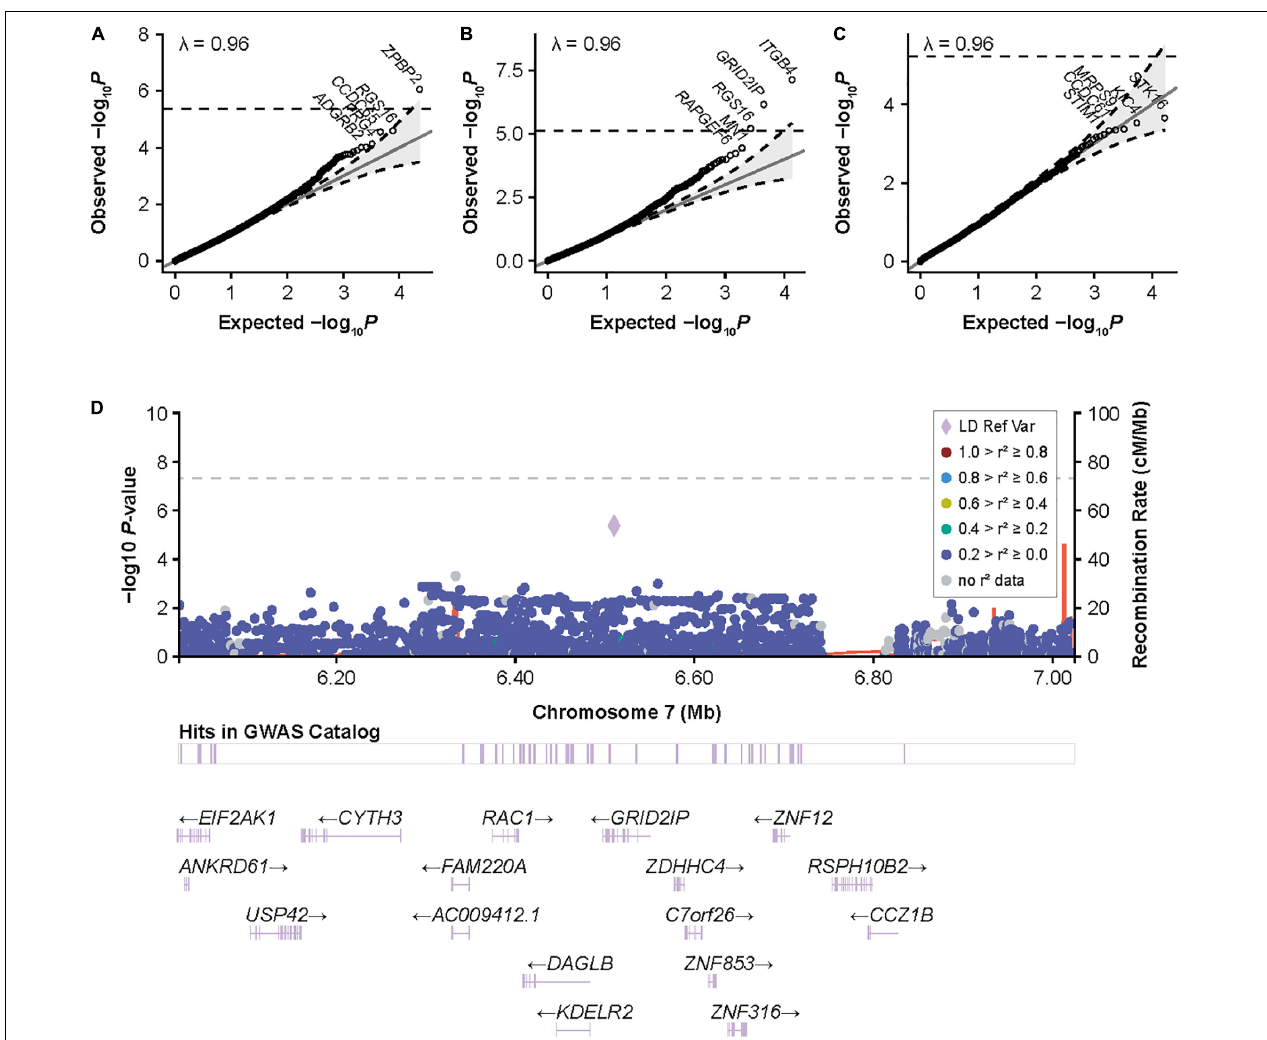
FIGURE 3 | Gene-based associations with inhibitors and high-titer inhibitors in the European discovery cohort and around GRID2IP in participants with HA. (A) Quantile-quantile (QQ) plots for inhibitor status, (B) high-titer inhibitor status, and (C) inhibitor status in patients with intronic F8 inversions in the European discovery cohort for gene-based variant aggregation tests. Association P values were calculated using logistic mixed-model score tests using variant-set mixed-model association tests (SMMAT), adjusting for age, sequencing center, F8 mutation type, hemophilia A severity, and the first 3 principal components. (D) LocusZoom plot reporting single-variant generalized linear mixed-model association tests (GMMAT) score test P values of high-titer inhibitors in participants with hemophilia A around GRID2IP . Logistic mixed models were adjusted for age, sequencing center, F8 mutation type, hemophilia A severity, and the first three principal components. In contrast to the main single-variant analysis with high-titer inhibitor, all variants with an allele frequency > 1% were included to show the association with the top coding GRID2IP variant included in variant aggregation tests (rs61732374, P = 4 × 10 − 6 ). GRID2IP , glutamate receptor, ionotropic, delta 2 [ GRID2 ] interacting protein 1; GWAS, genome-wide association study; LD Ref Var, linkage disequilibrium reference variant; HA, hemophilia